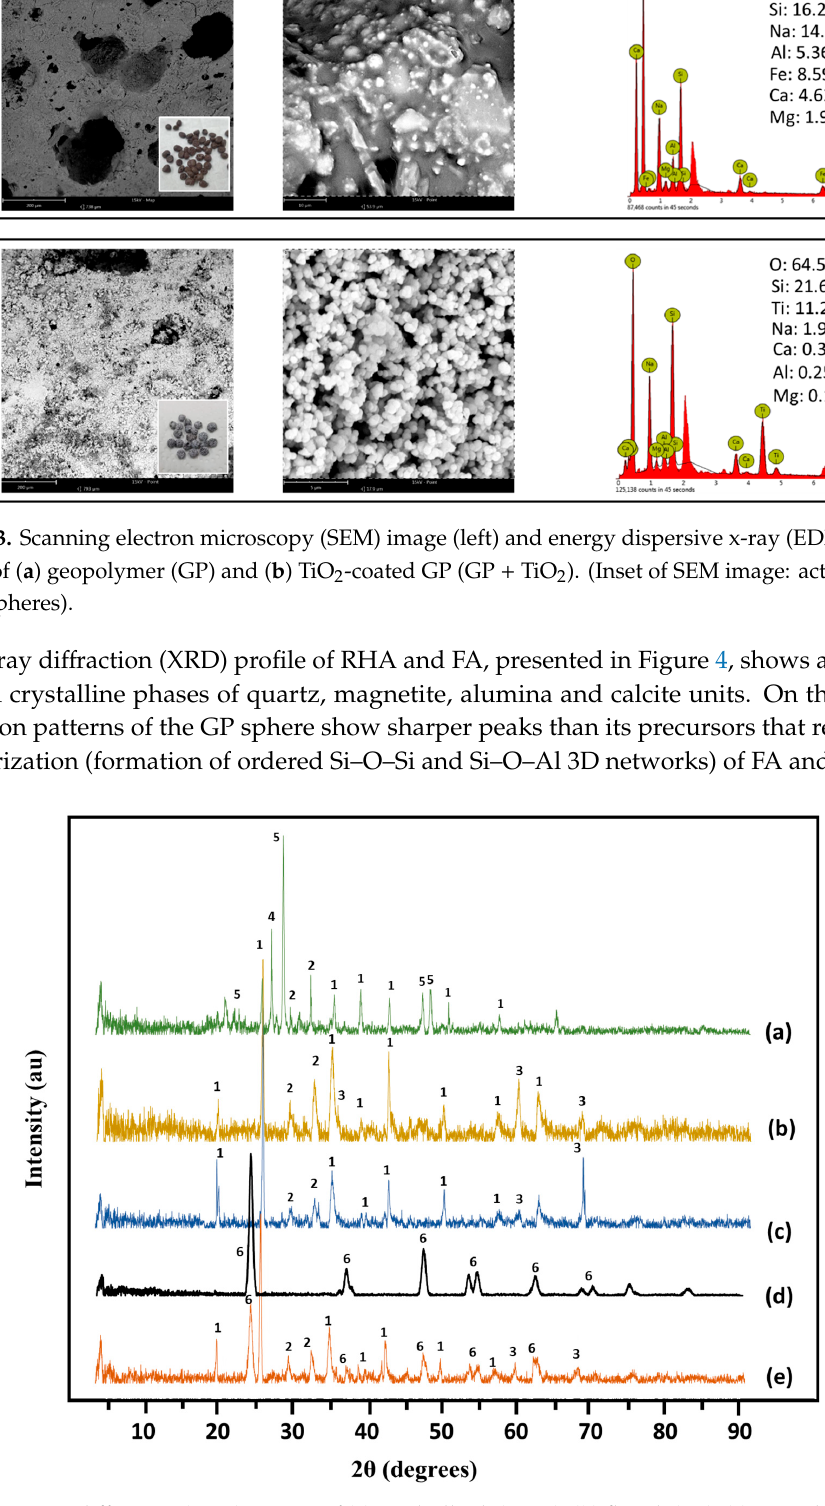
Figure 4. X-ray di ff raction (XRD) pattern of ( a ) rice hull ash (RHA), ( b ) fly ash (FA), ( c ) geopolymer (GP), ( d ) titania (TiO 2 ) and ( e ) TiO 2 -coated GP sphere (GP + TiO 2 ). 1—quartz; 2—magnetite; 3—alumina; 4—K 2 O; 5—calcite; 6—anatase. Peaks are assigned based on their corresponding Joint Committee on Powder Di ff raction Standards (JCPDS) di ff raction